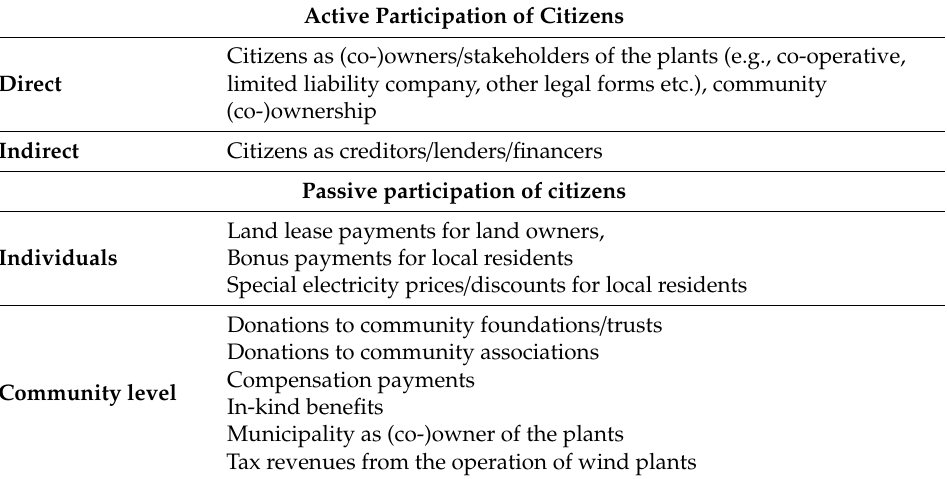
Table 1. Forms of active and passive financial participation of local communities and citizens in wind farms, adapted from